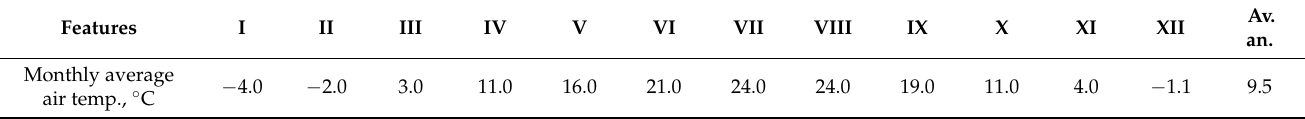
Table 1. Climate characteristics of the Pskem HPP construction